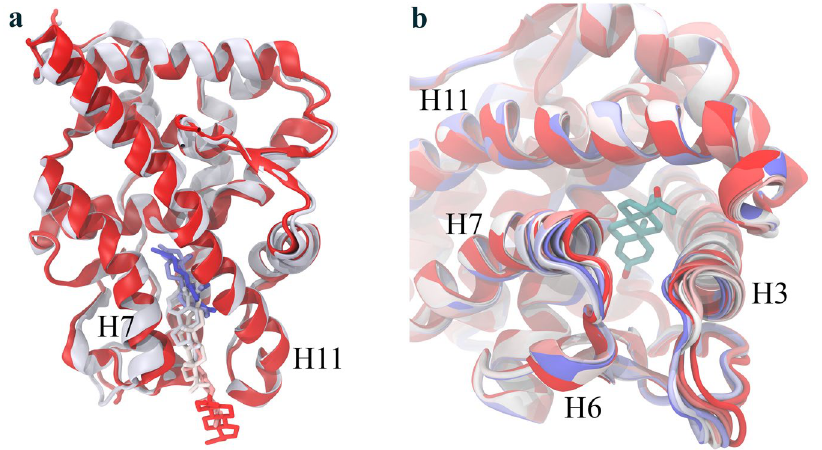
Figure 4. PR binding mechanism. Two different views of the ligand entrance and the plasticity upon progesterone binding in PR. (a) Different ligand snapshots along the binding with two protein structures highlighting the initial closed (red cartoon) and intermediate open states (white cartoon). (b) A closer zoom at the entrance region with the ligand shown in the native bound structure; same color-coding as in the (a) panel but for the ligand (shown with atom element colors).